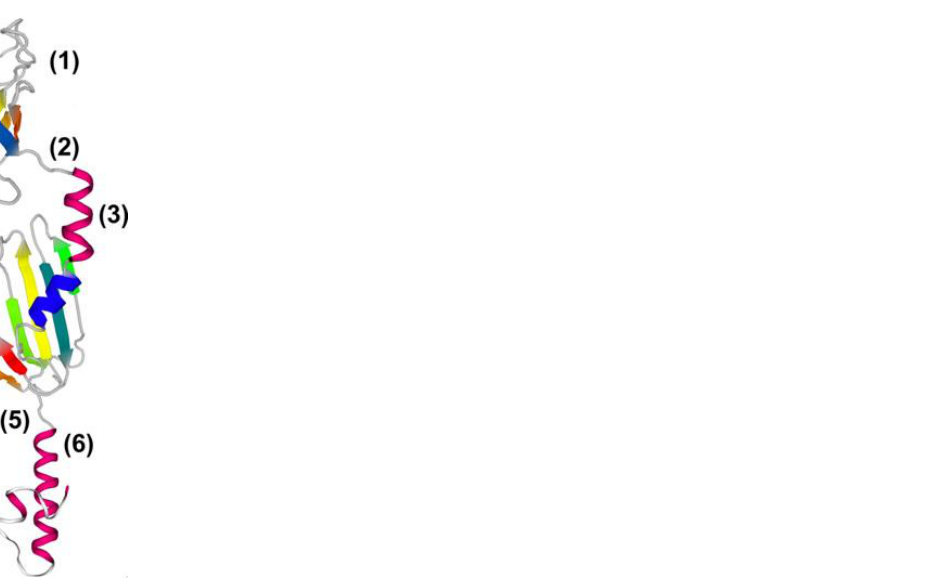
Figure 1. Schematic of the designed fusion protein containing seven components: ( 1 ) a streptavidin/rhizavidin hybrid peptide; ( 2 ) the uPA consensus sequence (SGRSA); ( 3 ) an alpha helix spacer [EAAK] 3 ; ( 4 ) the uPA binding domain of uPAR; ( 5 ) a FLAG tag for antibody recognition; ( 6 ) a HIS tag for isolation and identification; and ( 7 ) a PLAP sequence for GPI binding and anchoring to the